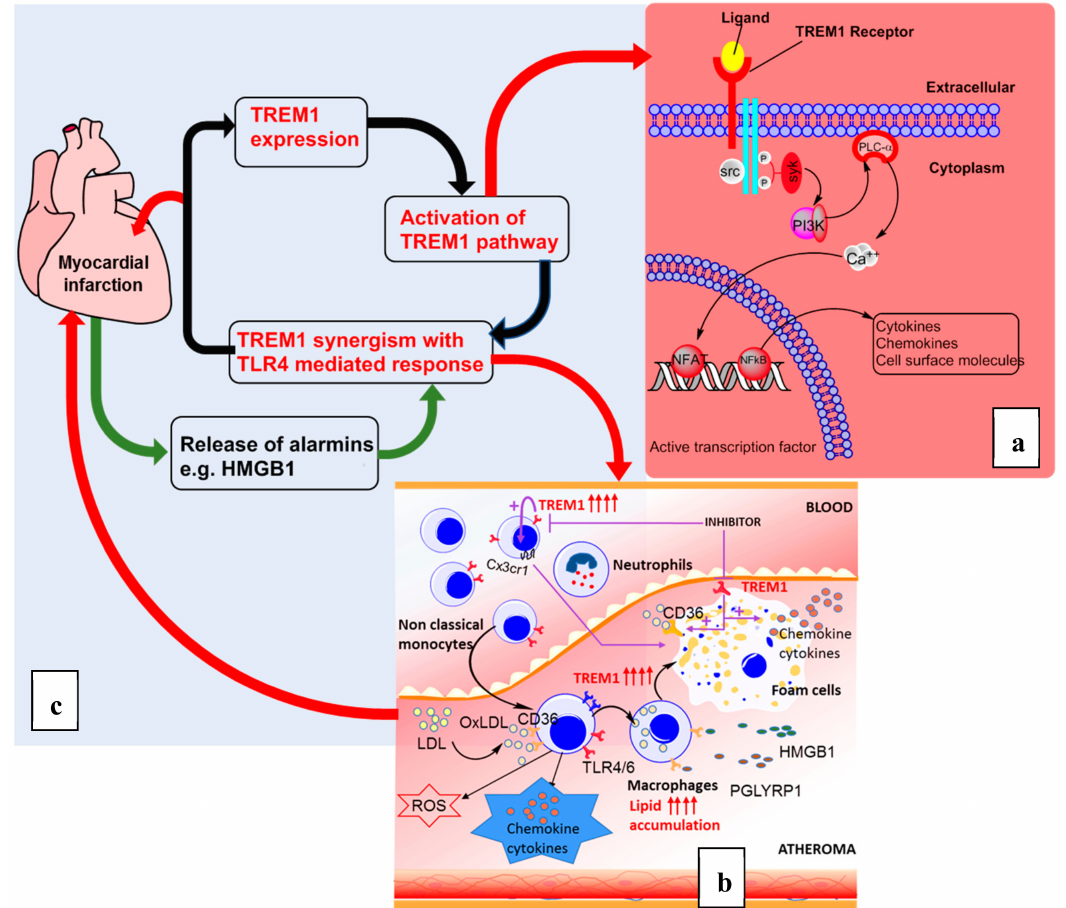
Figure 1. Triggering receptors expressed on myeloid cells-1 (TREM-1) in the pathogenesis of atherosclerosis leading to acute myocardial infarction. ( a ) oxidized low density lipoprotein (oxLDL) concentration elevation in the plasma induces TREM-1 upregulation and its ligand interaction, leading to downstream signaling. TREM-1 interacts with DAP-12 to induce proinflammatory cytokines, chemokines, and cell surface molecule transcription through PI3K and PLC- α and nuclear factors NFAT and NF- κ B. ( b ) The chronic inflammation condition induces the proliferation, recruitment, and differentiation of monocytes to macrophages which, in turn, uptake the oxLDL to form foam cells. It also induces the proliferation of smooth muscle cells (SMCs) that play a similar role. Altogether they form the atheroma. ( c ) The destabilization of the atheroma plaque causes coronary artery clog, resulting in acute myocardial infarction (AMI). During AMI, TREM-1 upregulation also induces a deleterious cardiac wall scar, which is a source of heart